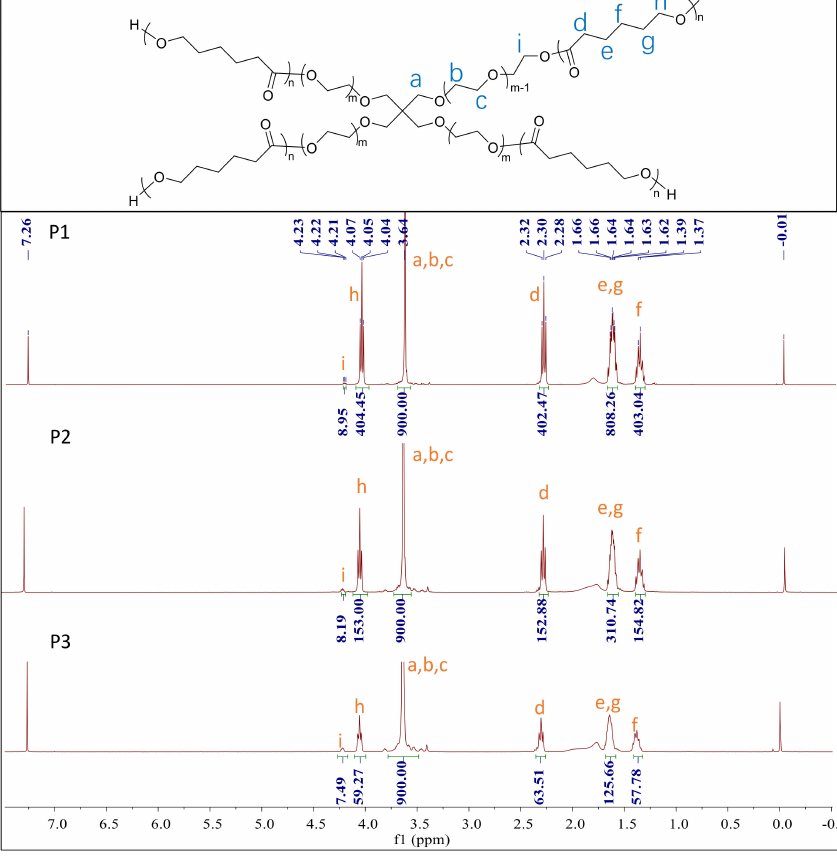
Figure 1. 1 H-NMR spectra and analysis of P1 – P3